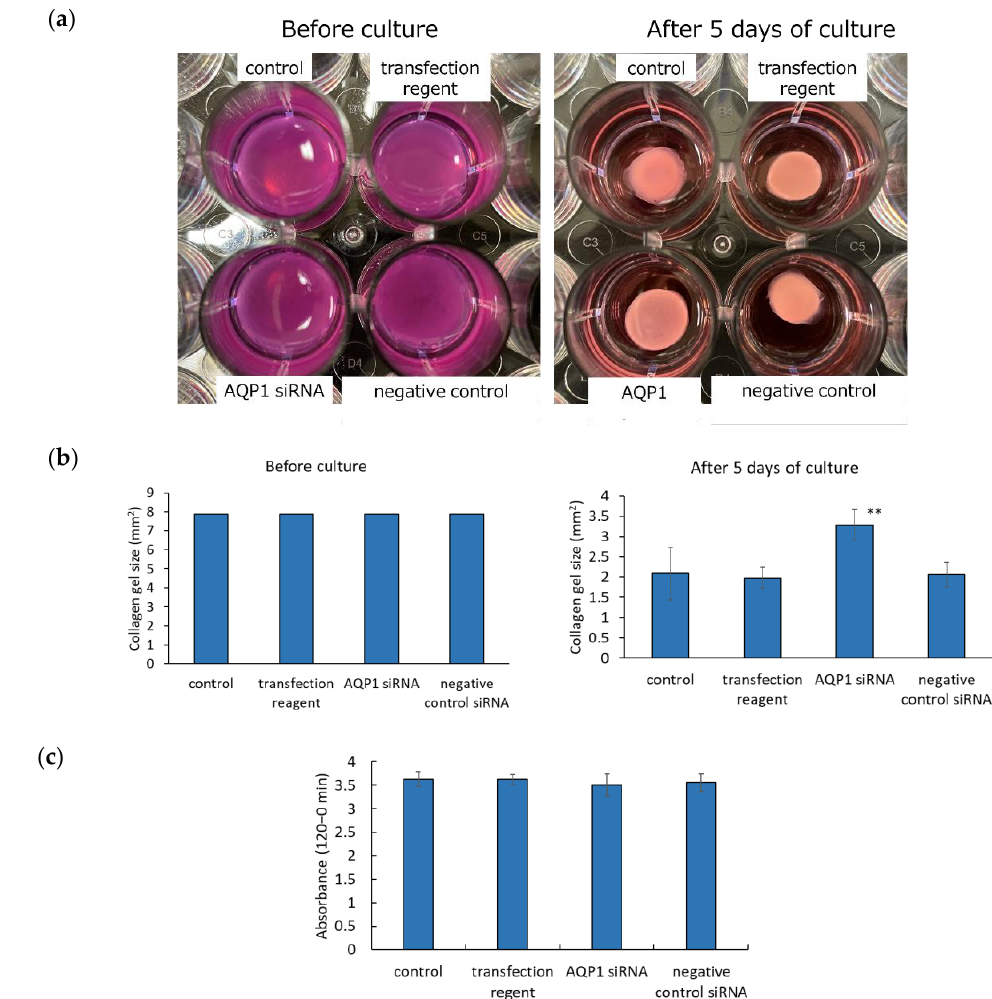
Figure 3. Collagen gel contraction of cultured human dermal fibroblasts. ( a ) Images of collagen gel before and after 5 days of culture. ( b ) Area of collagen gel after 5 days of culture. **: p < 0.01 vs. the transfection reagent. The figures show the means ± standard deviations ( n = 3). ( c ) Relative cell count after 5 days of culture.